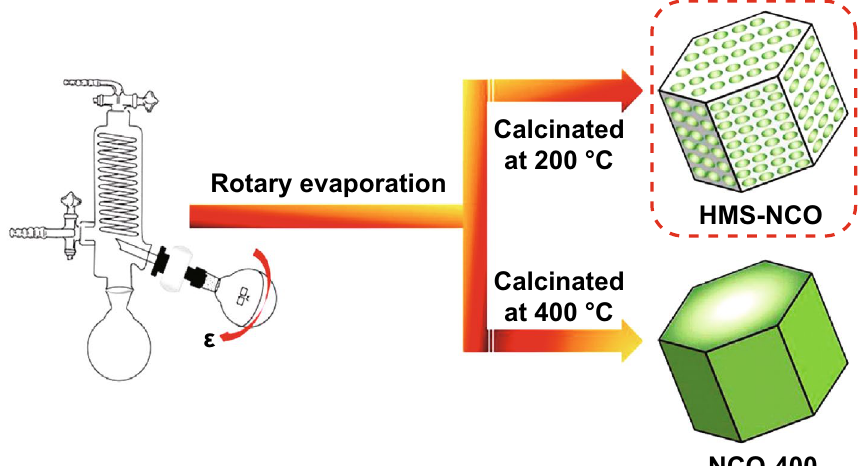
Fig. 15 Schematic illustration of the synthesis of hexagonal mesoporous structured NiCo 2 O 4 (HMS-NCO) and NiCo 2 O 4 calcined at 400 °C (NCO-400). Reproduced with permission from Ref. [161]. Copyright © 2018 Elsevier Ltd and Techna Group S.r.l.